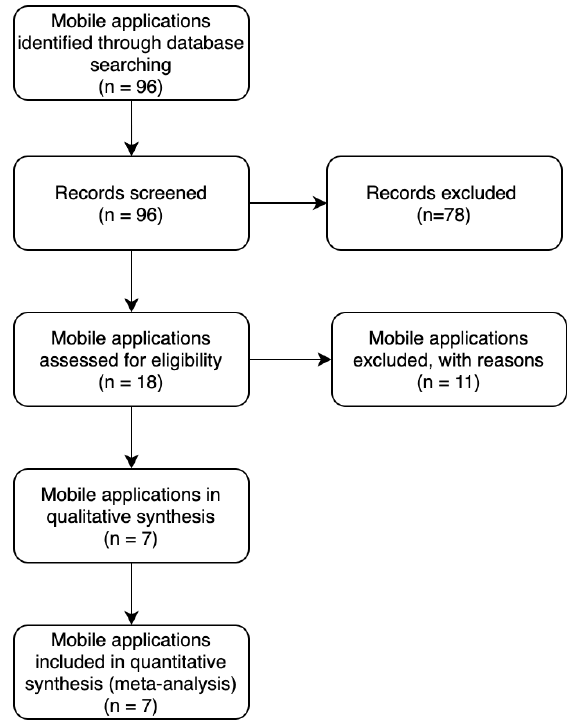
Figure 3. Mobile Applications